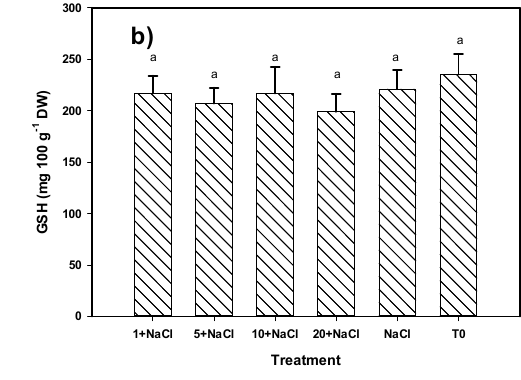
Figure 2. Photosynthetic pigments in leaves of tomato plants under NaCl stress and an application of Se NPs. T0: Control. NaCl: NaCl-only treatment. 1, 5, 10, and 20 + NaCl: Represent the amount of Se